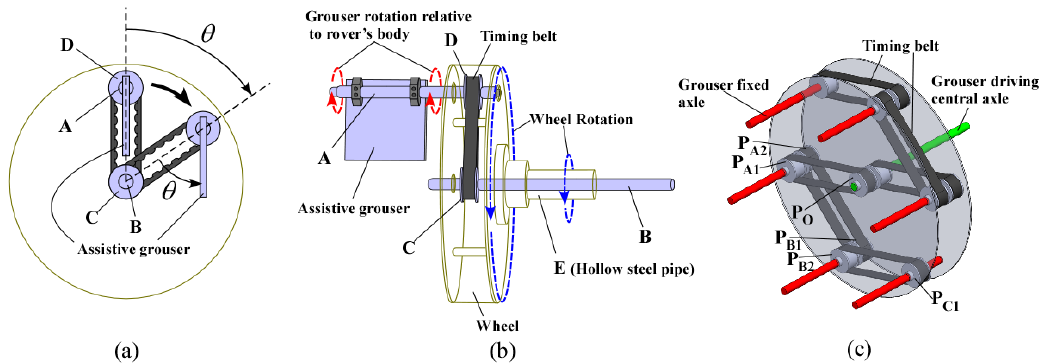
Figure 5. Configuration of the assistive grouser mechanism: ( a ) Side view of wheel rotated θ degrees with single assistive grouser; ( b ) Parts of the assistive grouser mechanism; ( c ) Timing belt and pulley arrangement for assistive grouser mechanism. arrangement for assistive grouser